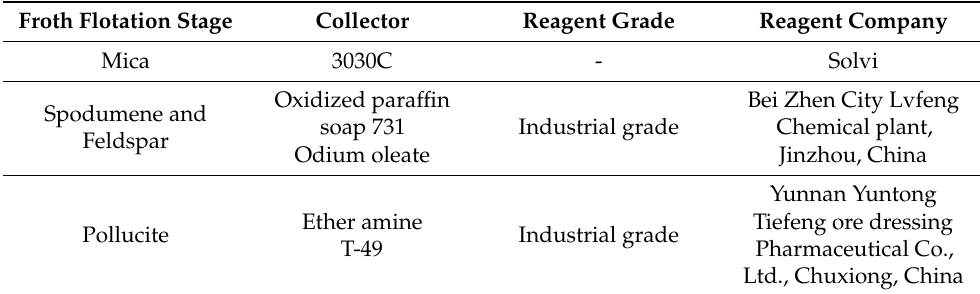
Table 1. Collector in different froth flotation states.